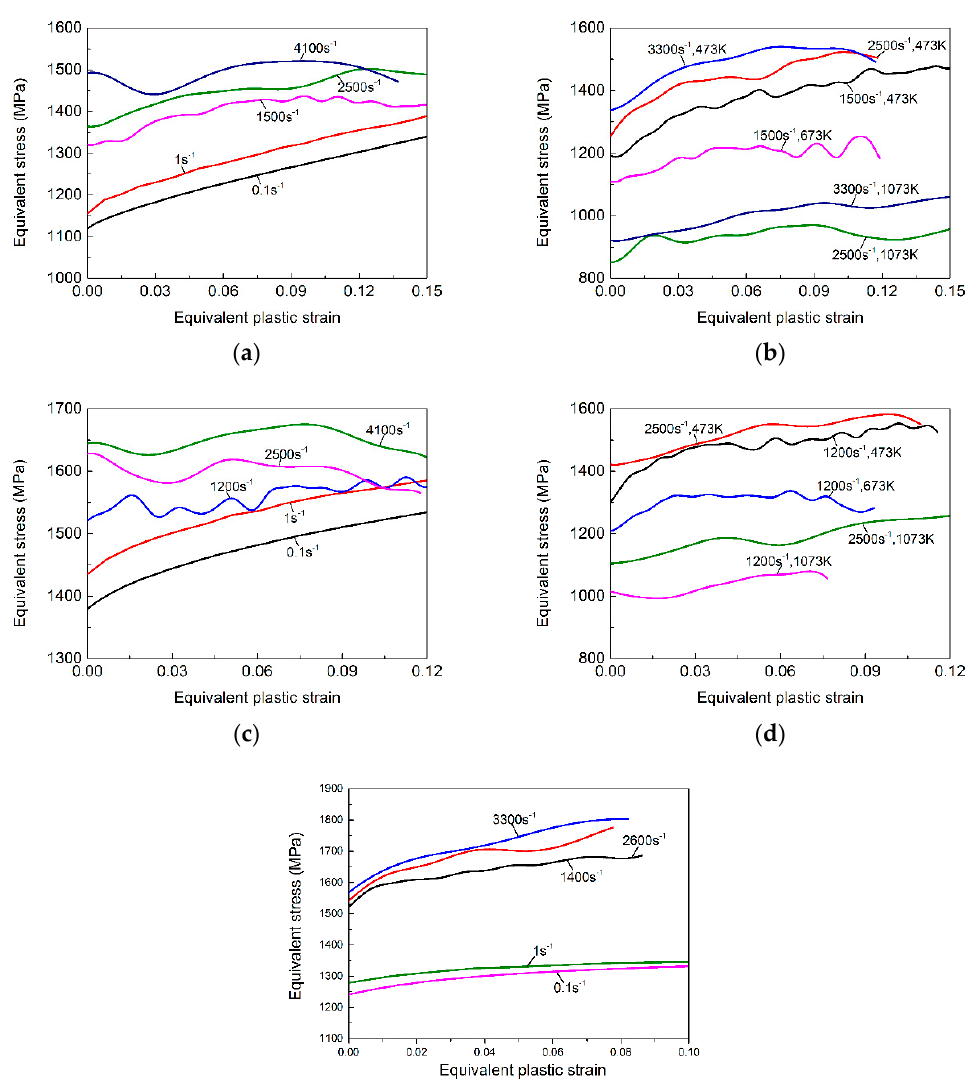
Figure 7. Selection of yield point.